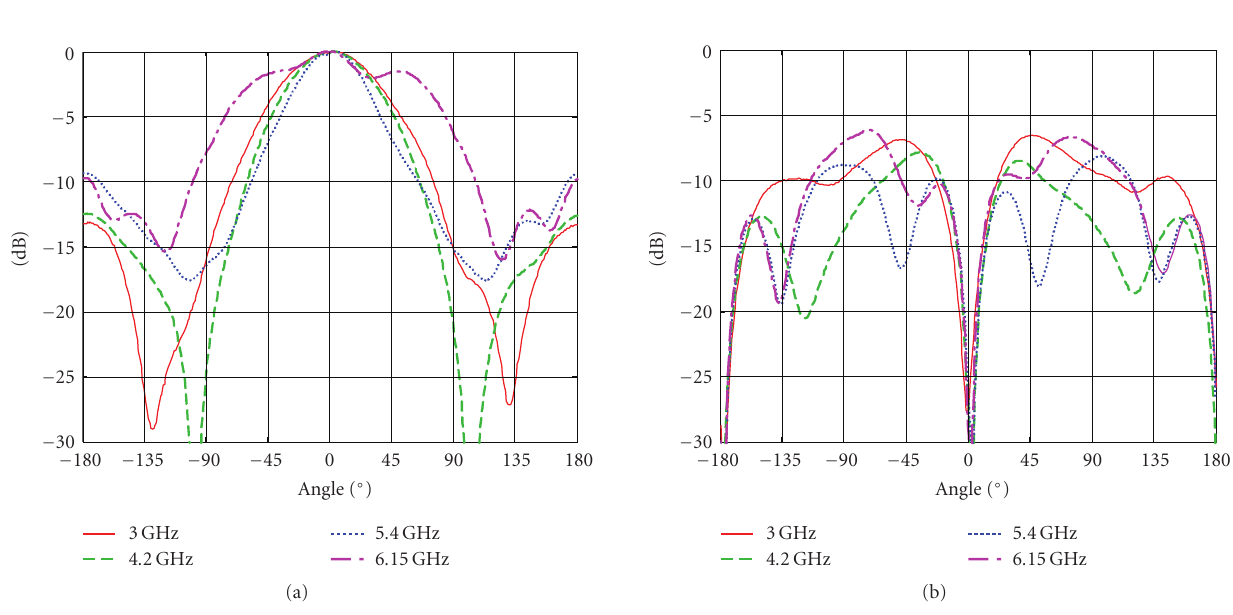
Figure 3: Radiation pattern in the E-plane.